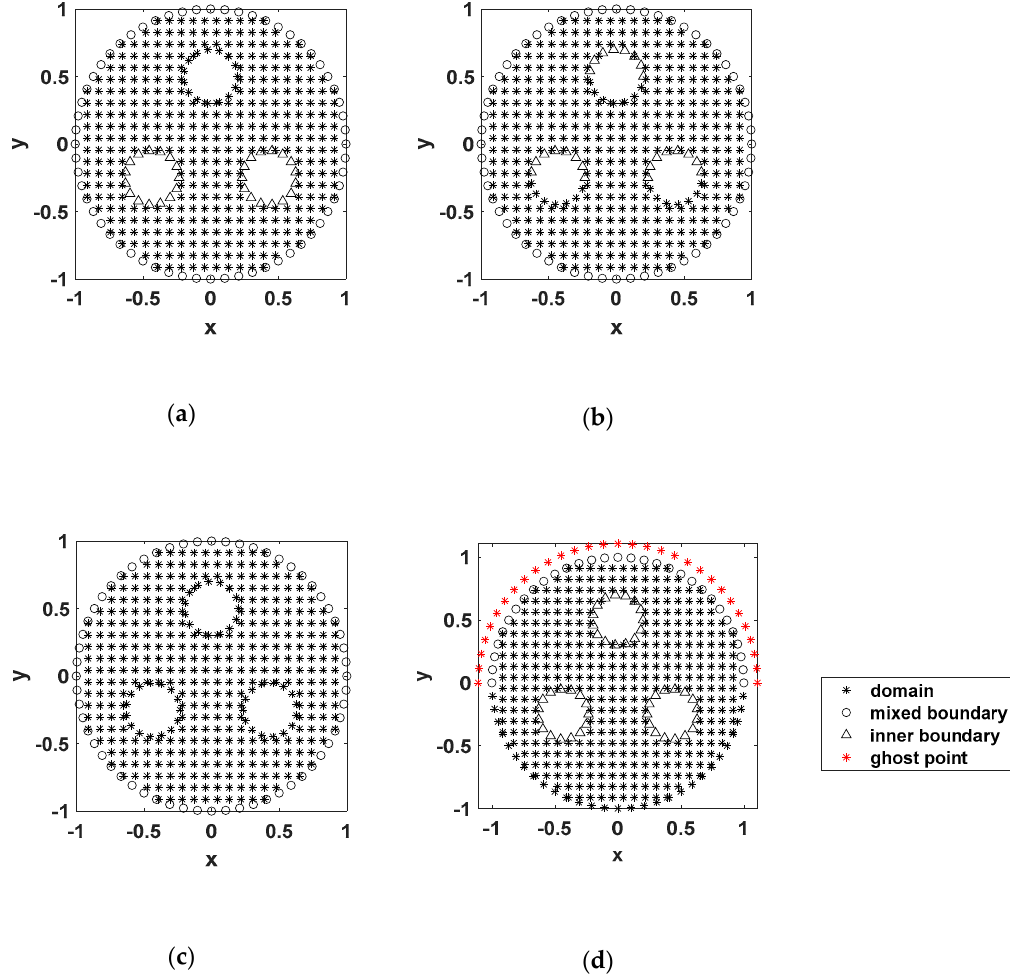
Figure 15. Discretization of type two multiply connected domains: ( a ) unknown upper inner boundary; ( b ) three half unknown inner boundaries; ( c ) unknown inner boundaries; ( d ) half unknown outer boundary.